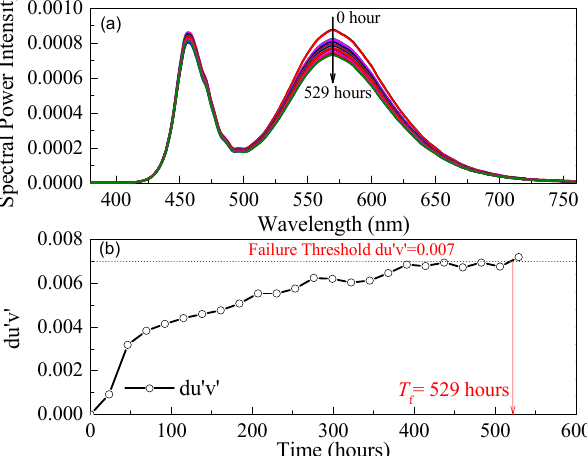
Figure 2. ( a ) Spectral power distribution (SPD) data collected under the accelerated degradation test; ( b ) color shift failure time T f = 529 h defined as when du ′ v ′ = 0.007.